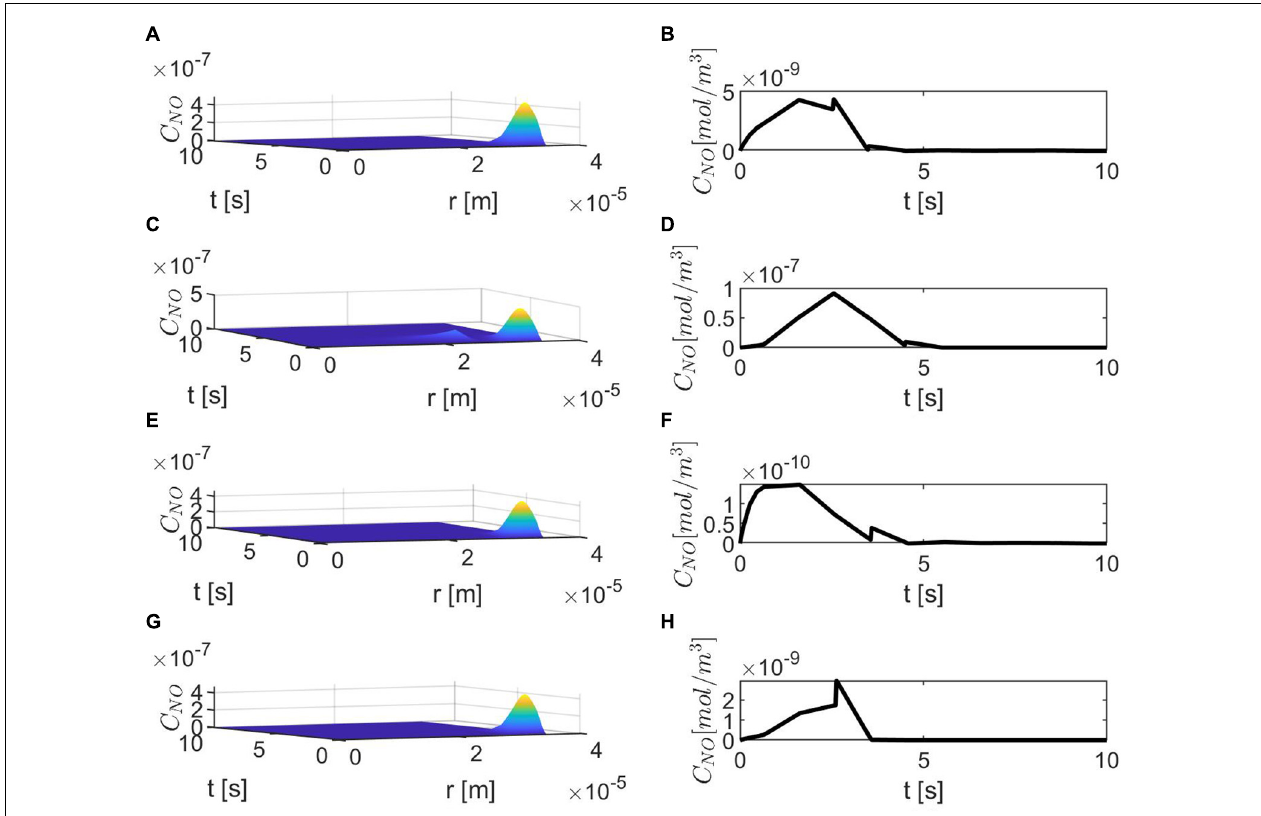
FIGURE 3 | Spatiotemporal variations of C NO (A,C,E,G) and its corresponding temporal profiles at r = a + h , the outer boundary of the endothelium, (B,D,F,H) for ε = 1 , p = q = 0 . 5, (A,B) E = 6 × 10 3 N / m , γ = 0 . 75 , ˜ λ = 6 . 5325 × 10 3 s − 1 , (C,D) E = 6 × 10 4 N / m , γ = 1 . 25 , ˜ λ = 6 . 5325 × 10 3 s − 1 , (E,F) E = 6 × 10 3 N / m , γ = 0 . 75 , ˜ λ = 13 . 065 × 10 3 s − 1 , and (G,H) E = 6 × 10 4 N / m , γ = 1 . 25 , ˜ λ = 13 . 065 × 10 3 s − 1